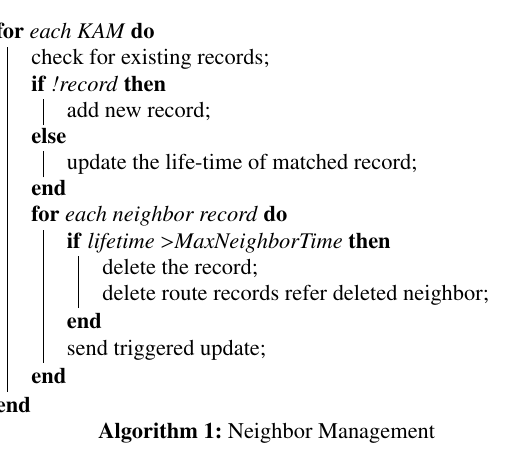
Figure 5: Route Message